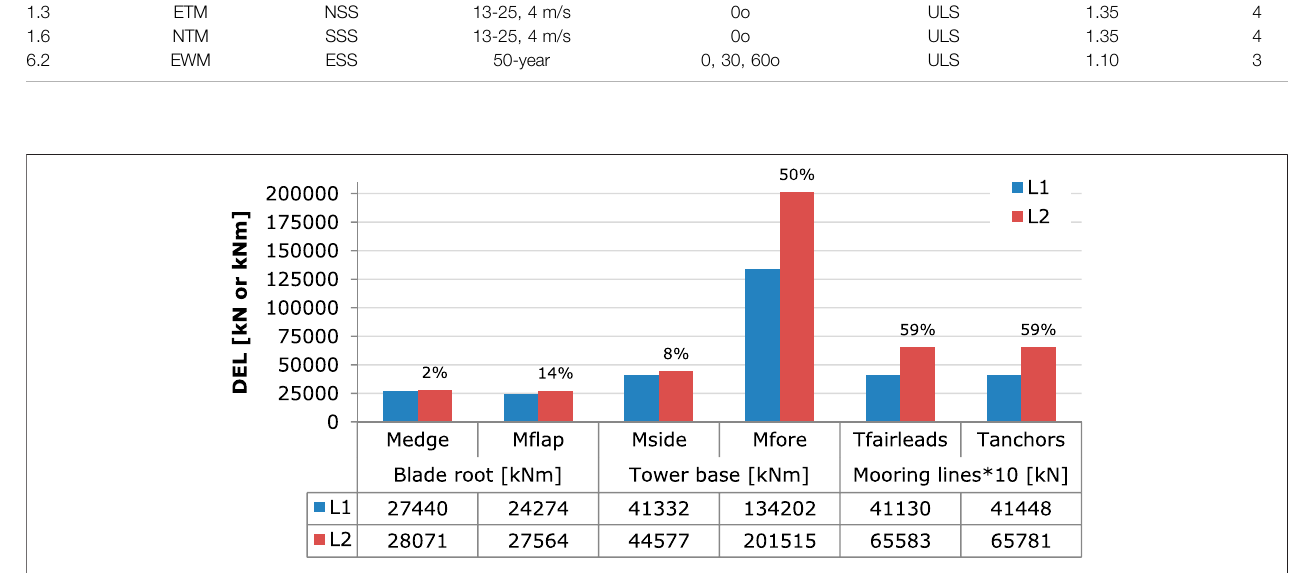
FIGURE11| Comparison ofDELsofbladerootedgewise(Medge)and fl apwise (M fl ap) moments,towerbaseside-side(Mside)and fore-aft(Mfore)moments,and mooring line tension at fairleads and anchors at L1 and L2 locations based on DLC1-2. The relative percentage difference with respect to L1 is also provided above the bars.